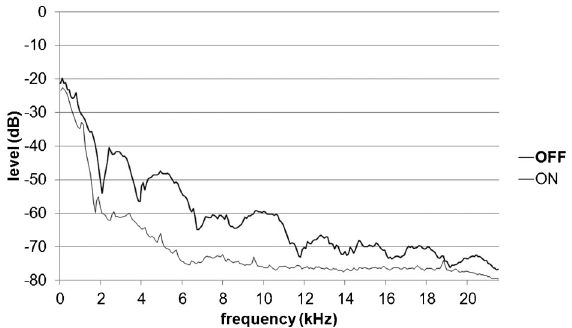
Figure 2. Sound spectra produced by a standard MRI sequence [soft-tone (OFF)] and silent sequence [soft-tone (ON) level 5]. Mean attenuation was 12 dB in the comparison between standard and silent spectra (range: 86-21963